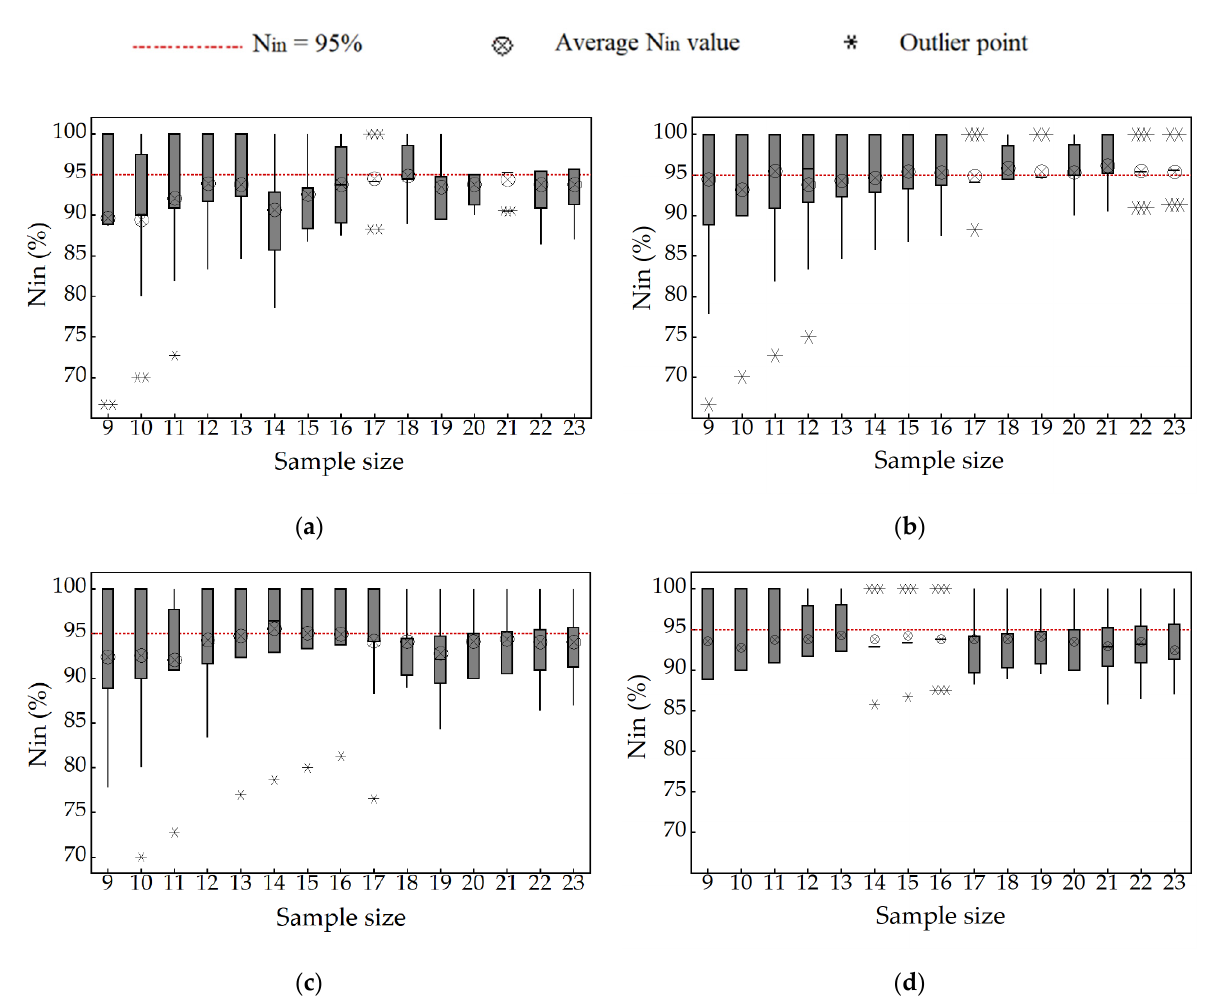
Figure 3. The changes in the percentage of measured values within the confidence bound (N in ) in different sample size (SS) values for all entropy models. ( a ) Tsallis entropy, ( b ) Shannon entropy, ( c ) Shannon PL entropy, and ( d ) Renyi entropy.